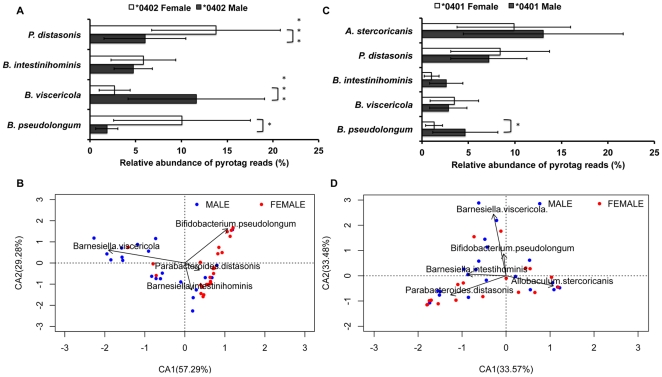
Sex based relative abundance of OTUs in the fecal microbiomes of *0401 and *0402 mice.(a) *0402 females (n = 24) show significantly higher relative abundances of Bifidobacterium-Parabacteroides OTUs compared to males (n = 21), whose microbiomes present significantly higher levels of Barnesiella viscericola. (b) Correspondence analysis plot displays sex-based correlation between OTUs in *0402 mice. (c) Significantly higher relative abundances of Bifidobacterium sp. were observed in *0401 males (n = 22) compared to females (n = 19), (d) despite loss of dynamic sex based differences in the fecal microbiomes of *0401 mice. Percentages in parentheses in the CA plots describe the amount of variation explained by each axis. Data are presented as mean ± S.E. *P<0.05, **P<0.01, ***P<0.001.